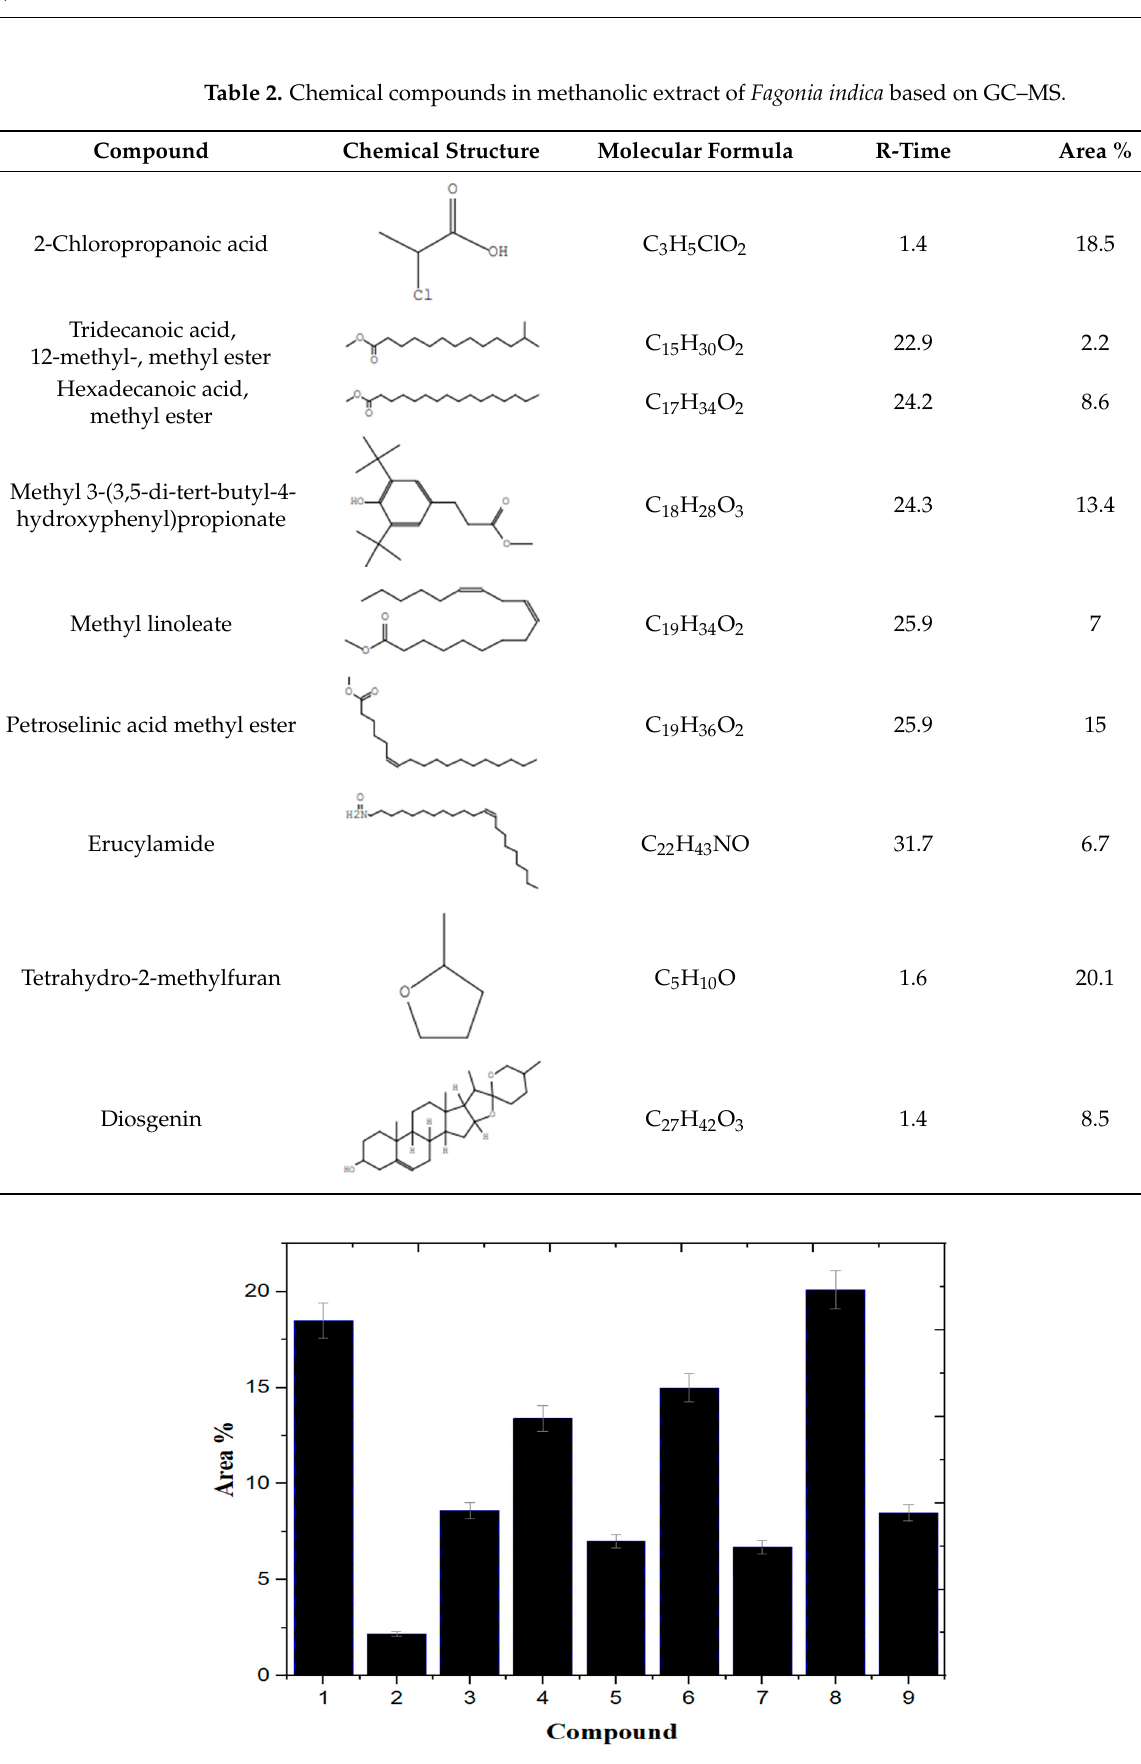
Figure 3. Percentages of chemical compounds extracted from Fagonia indica methanol